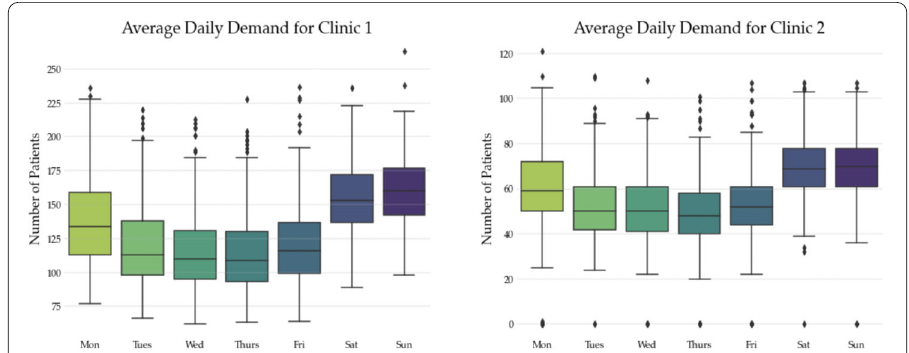
Figure 4 Average daily patient demand by day of the week across both